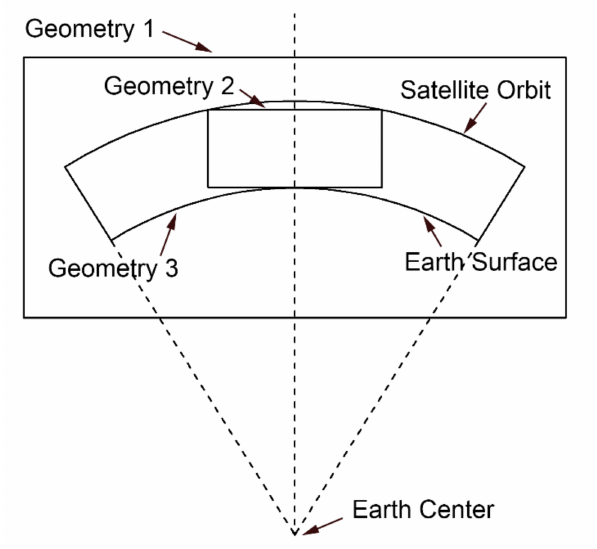
Figure 3. Diagram of the voxel geometries in computerized ionospheric tomography (CIT) (adapted from [26]). Geometries 1–3 correspond to a rectangle containing the annular region, a rectangle within the annular region, and an annular region,